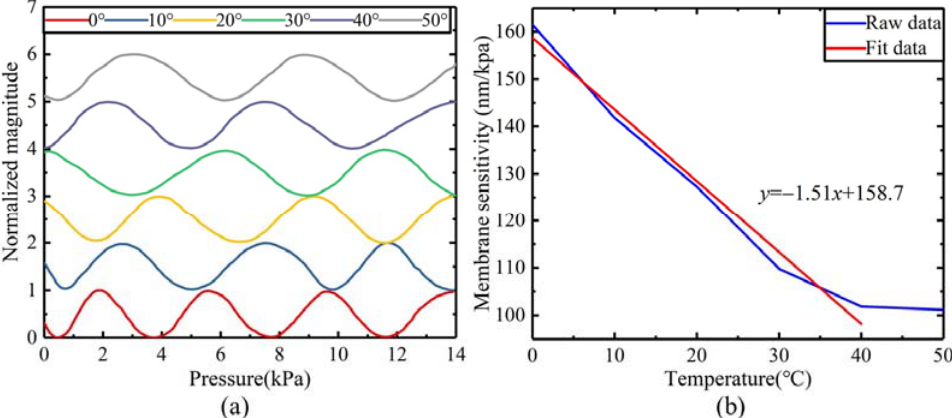
Figure 11. ( a ) Pressure responses of the sensor at different temperatures; ( b ) pressure sensitivity curve at different temperatures.